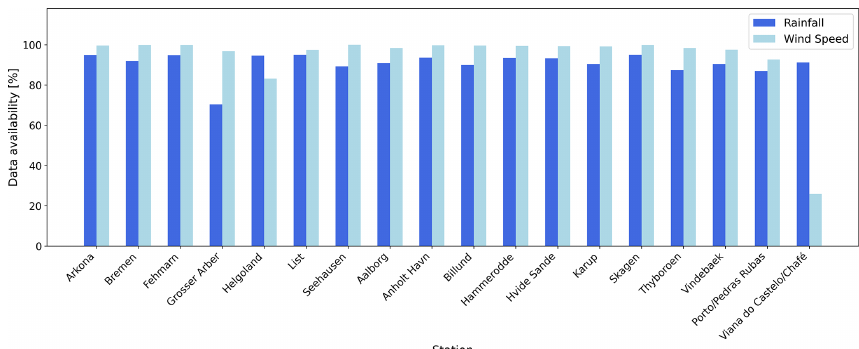
Figure 2. Availability of IMERG and in situ data after quality control and collocation.